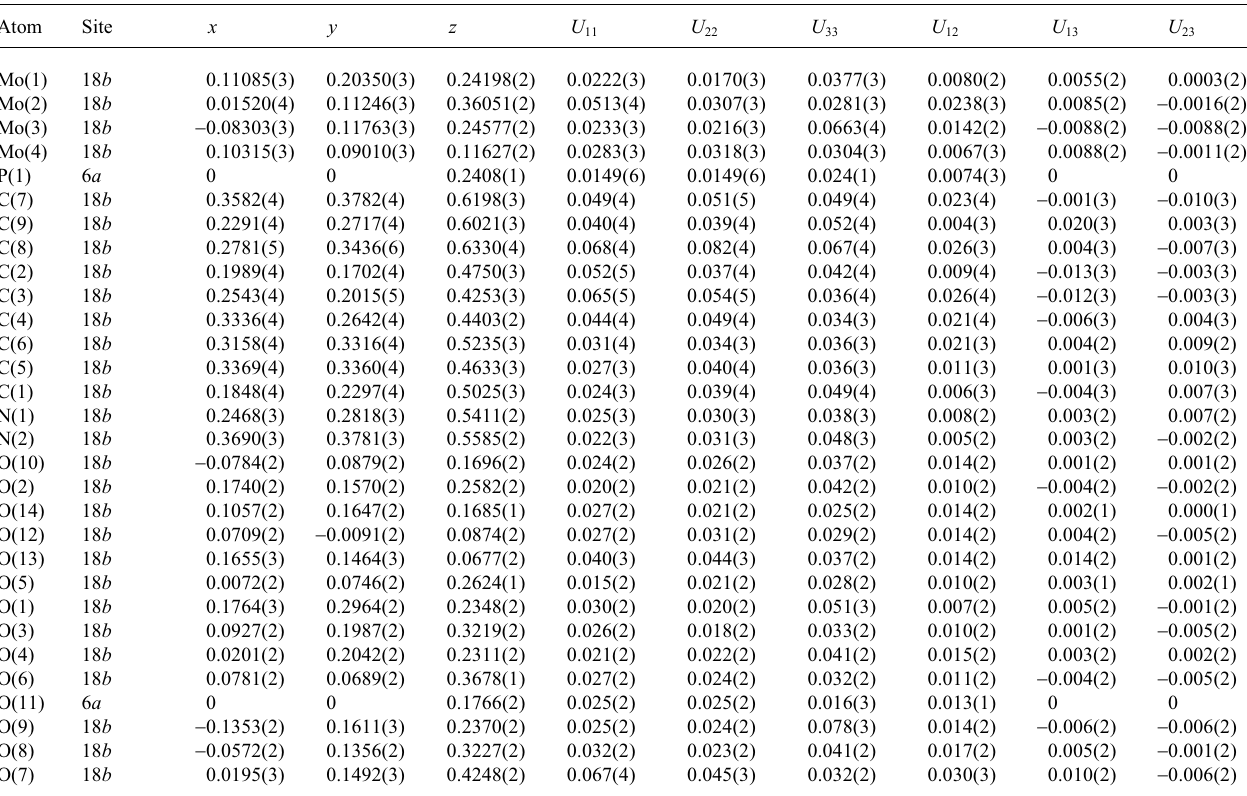
Table 3. Atomic coordinates and displacement parameters (in Å 2 )